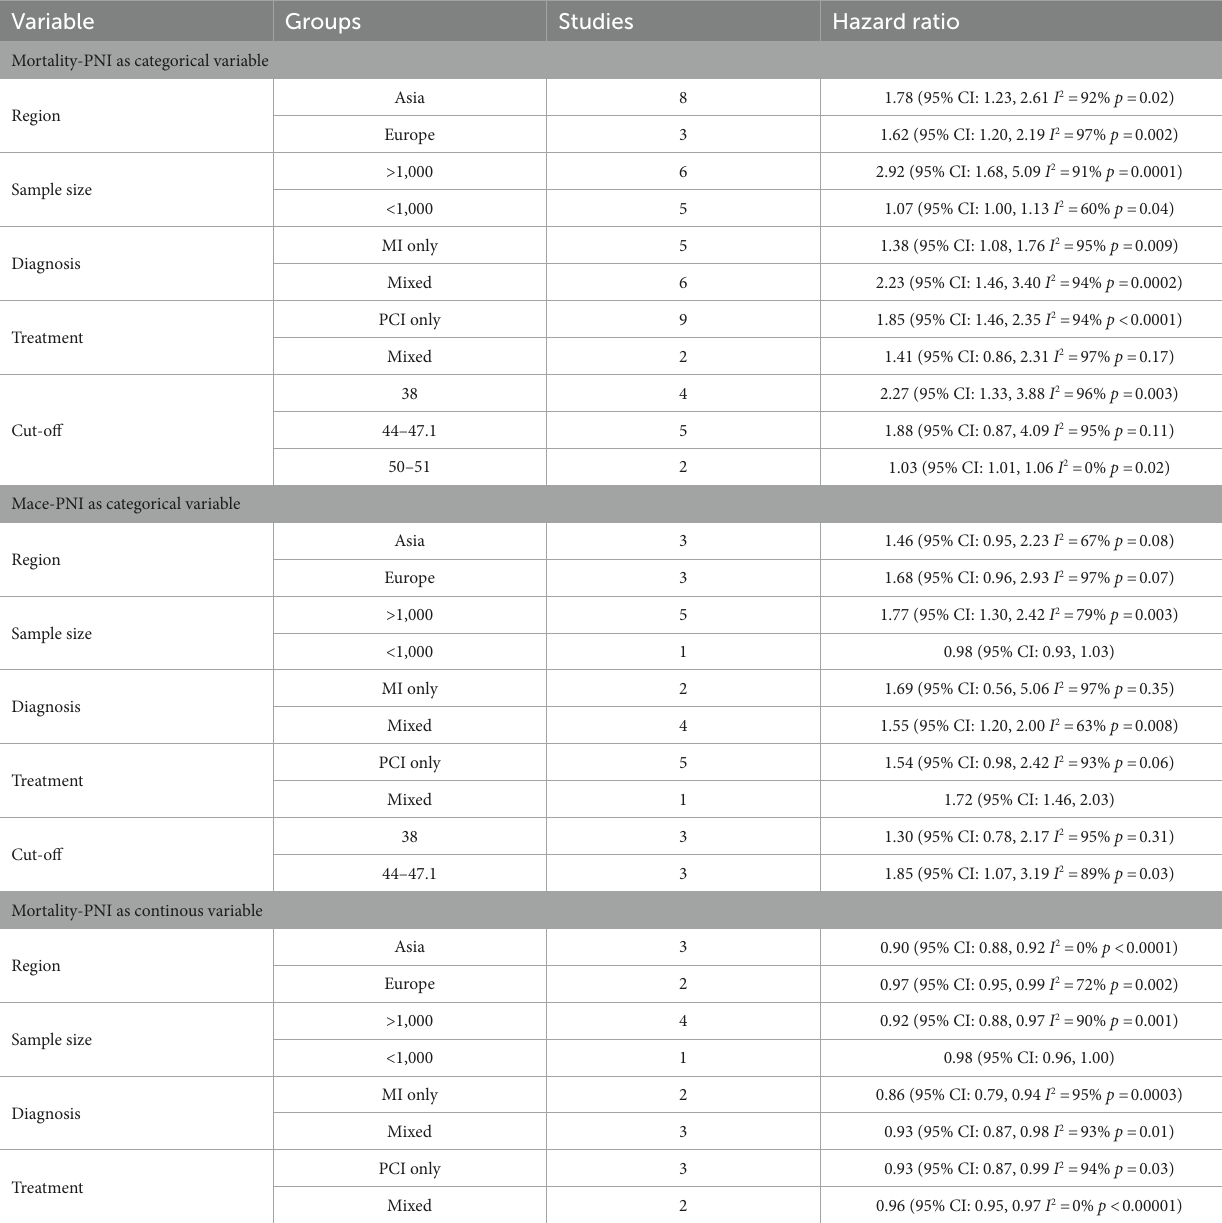
TABLE 2 Subgroup analysis. Variable Groups Studies Hazard ratio Mortality-PNI as categorical